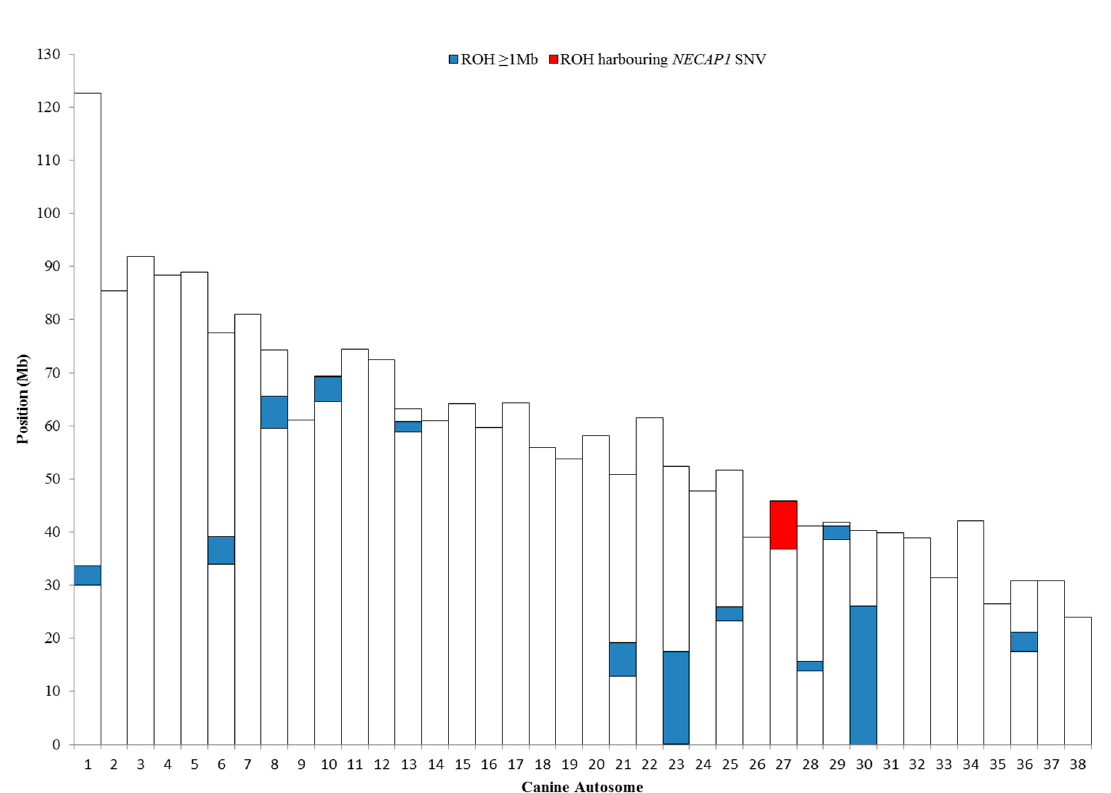
Figure 5. Chromosomal positions of runs of homozygosity (ROH) greater than 1 Mb in size (blue), on canine autosomes in the two GS PRA cases, as obtained through PLINK analysis. The red block indicates the 9.03 Mb ROH on chromosome 27 in which the NECAP1 variant lies.